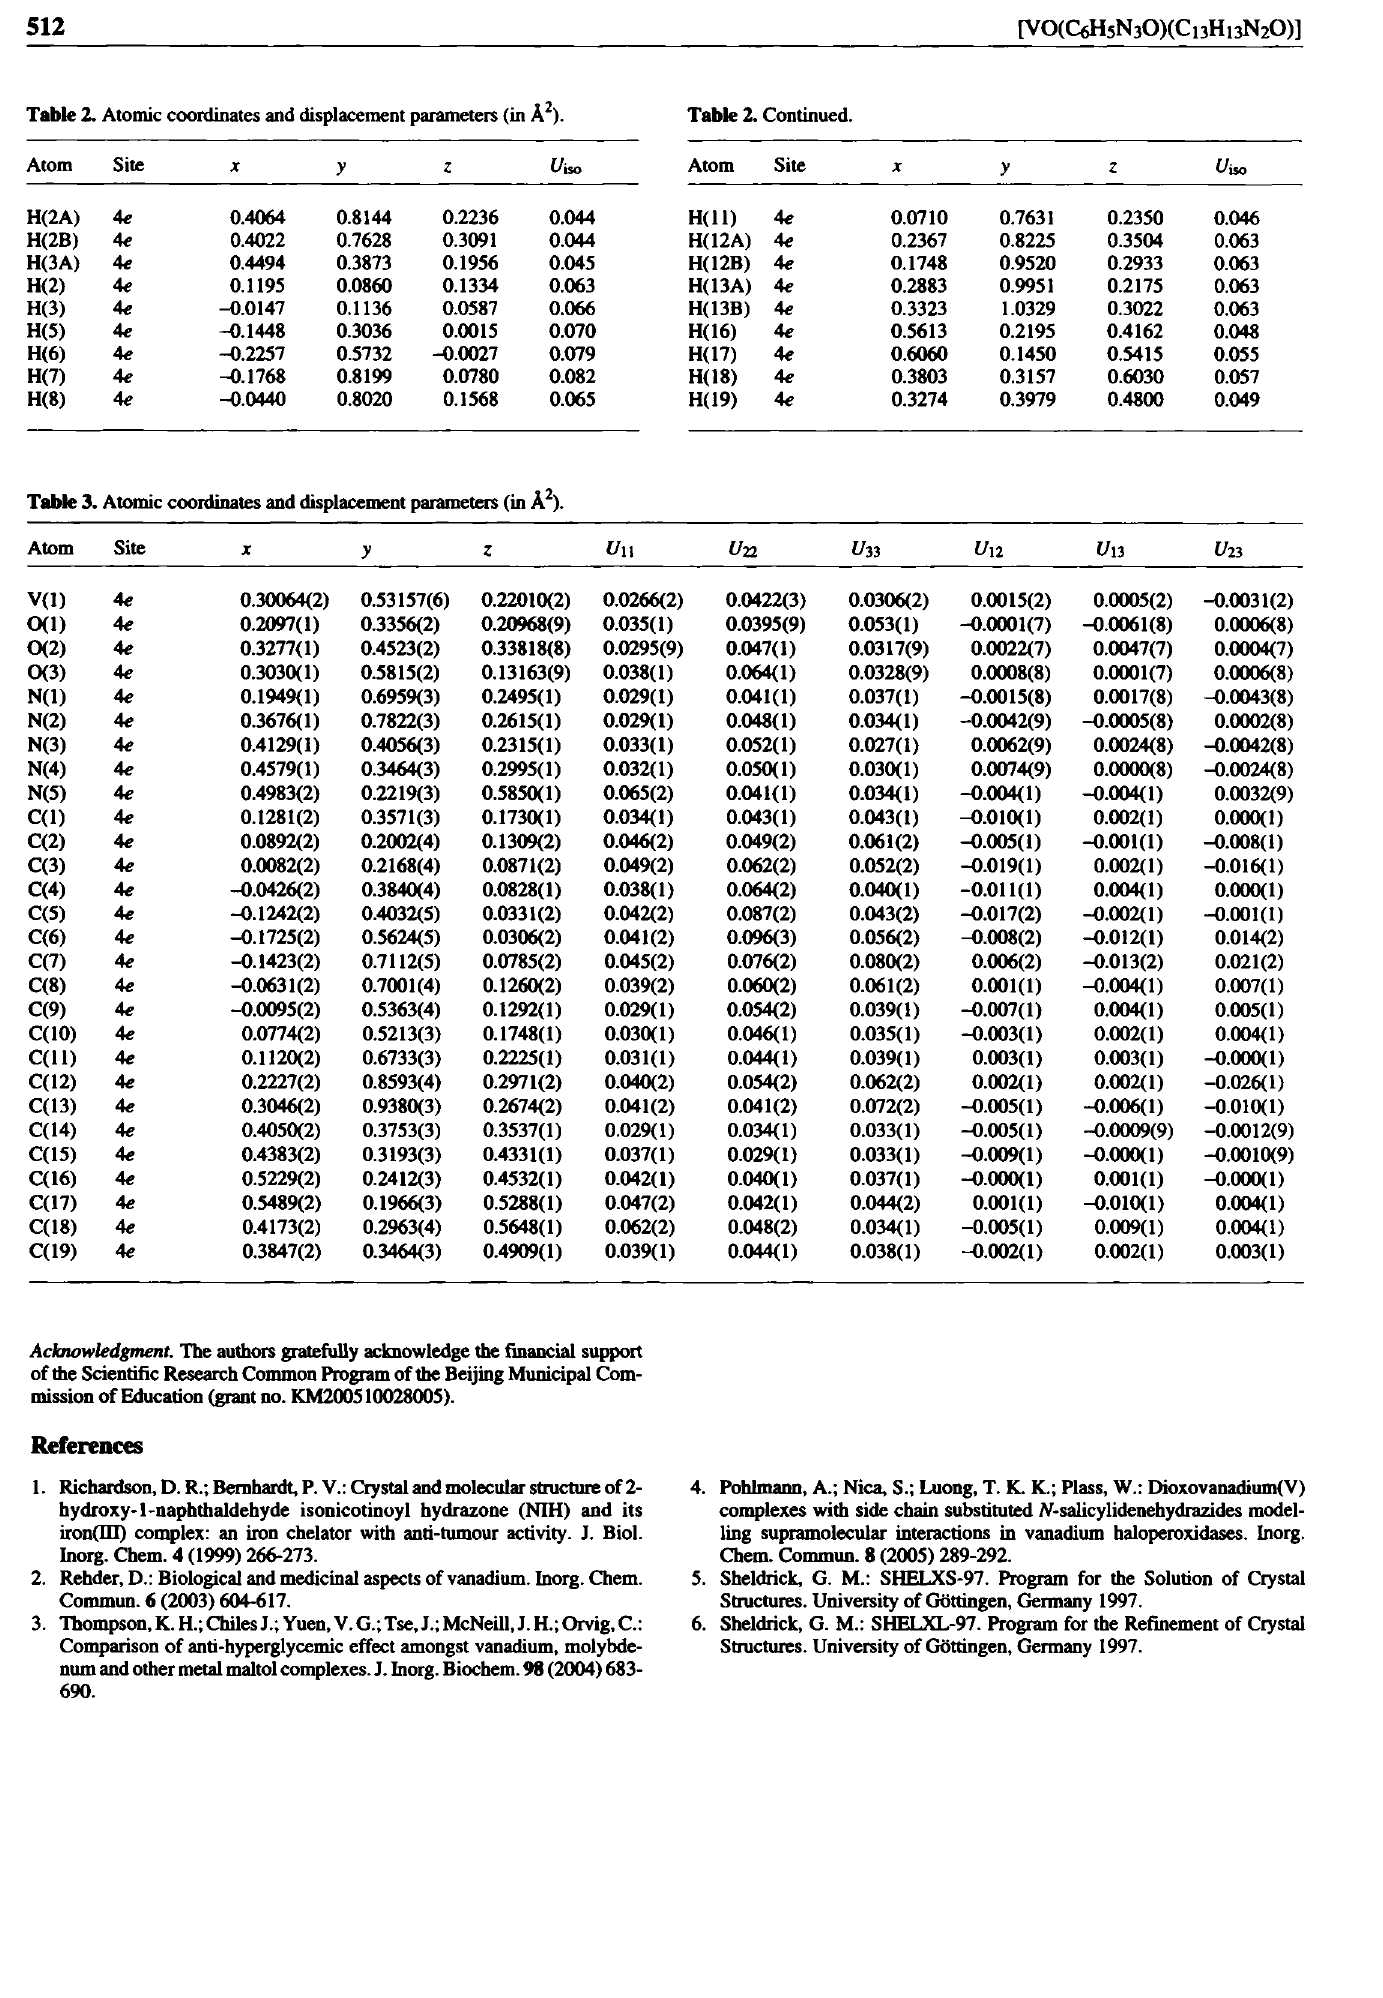
Table 2. Atomic coordinates and displacement parameters (in A 2 ).